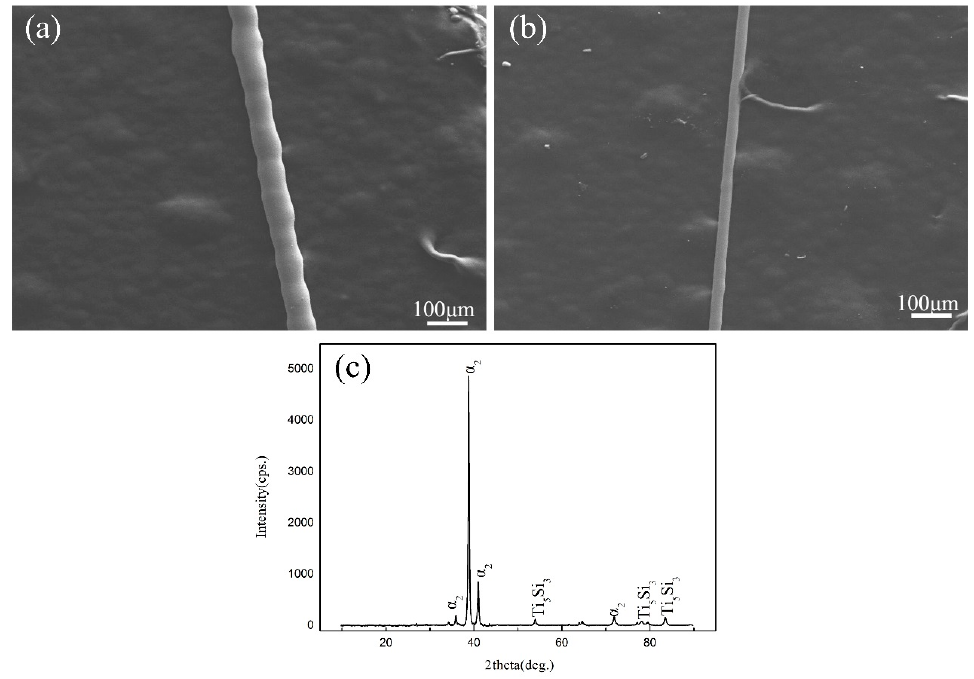
Figure 1. SEM micrograph of fibers with different rotation speeds and XRD results of fibers: ( a ) 2000 r/min; ( b ) 2600 r/min; ( c ) XRD results of fibers.